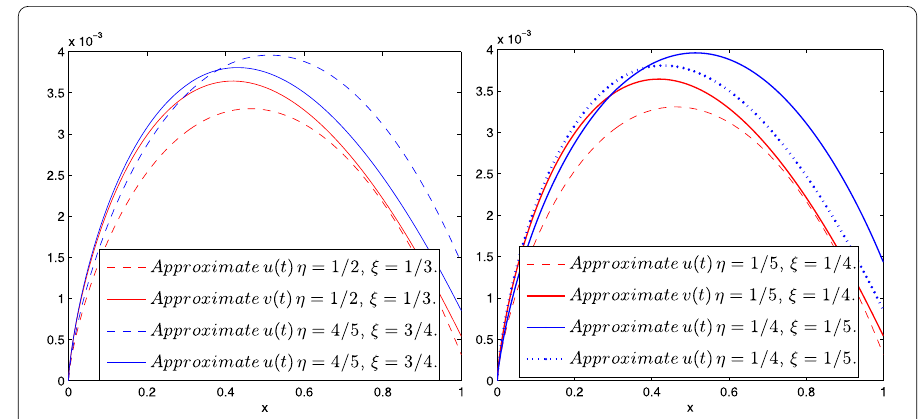
Figure 1 Plots of approximate solution ( u , v ) of Example 6.1 for different choices of parameters